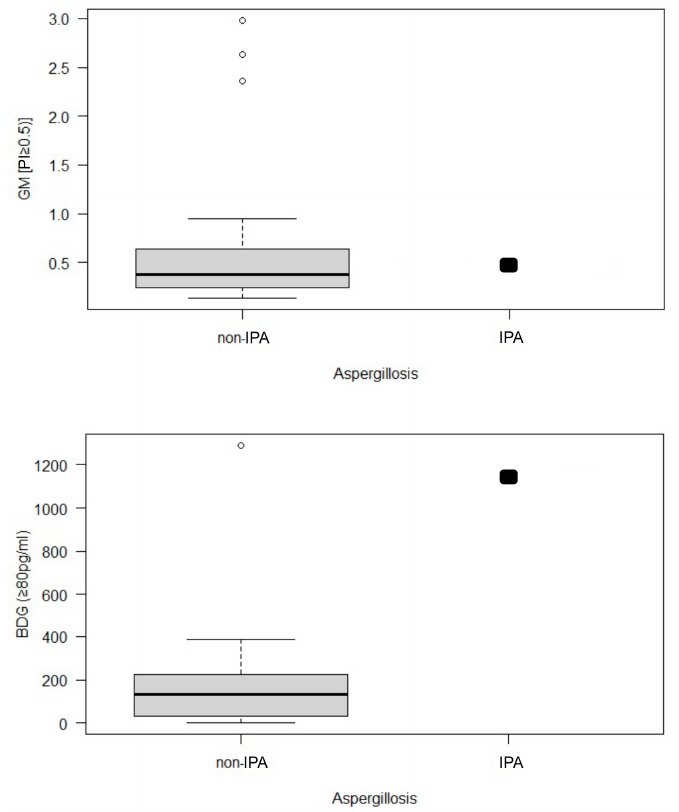
Figure 5. (Top) Serum biomarker concentrations in the group of horses without pulmonary aspergillosis (non-IPA, n = 23) and one horse with pulmonary aspergillosis. Serum galactomannan in the horse with pulmonary aspergillosis (index positivity = 0.478) and the control group (IQR = 0.375). (Bottom) serum (1,3)- β -D-glucan in the horse with invasive pulmonary aspergillosis (1142 pg/mL) and the healthy control group (131.5 pg/mL). Table 2. Aspergillus biomarkers in equine BALF and serum.